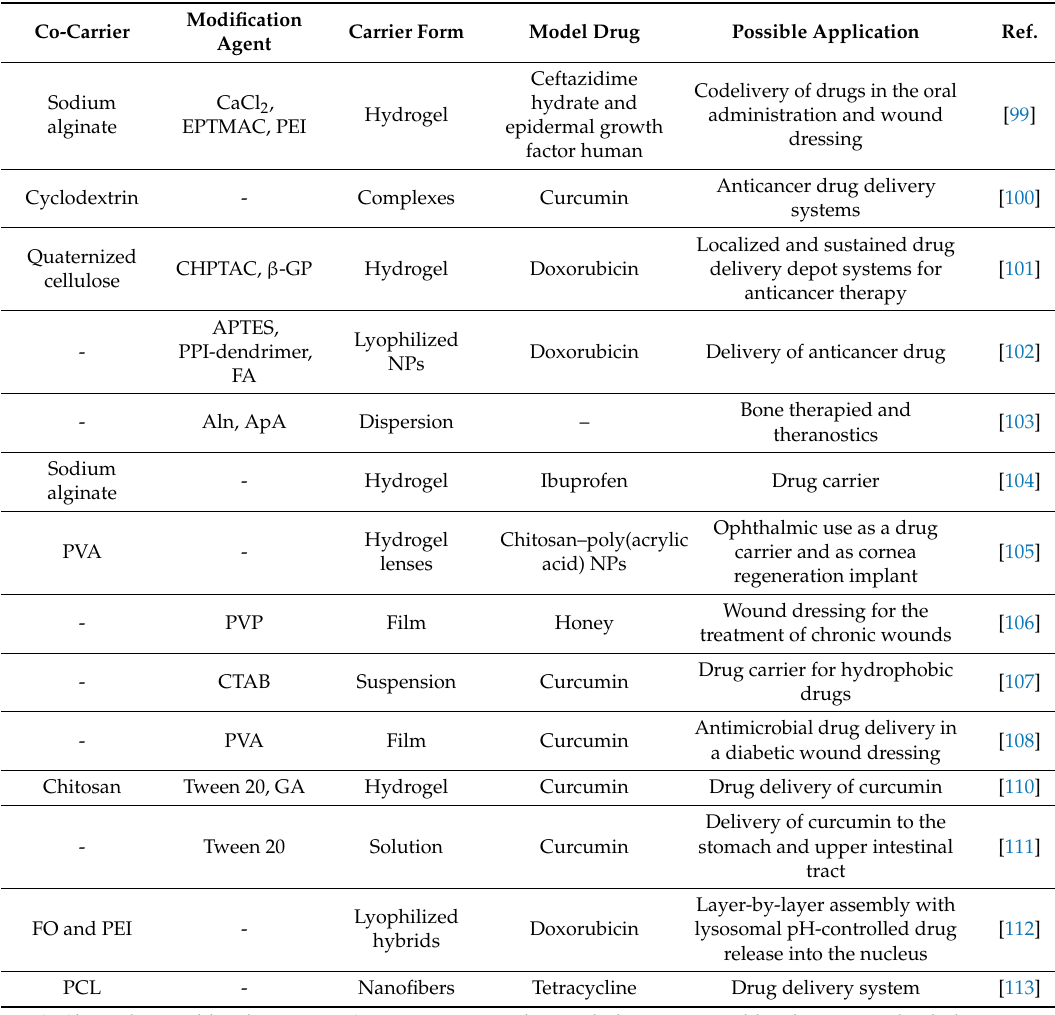
Table 1. Diverse CNC-based delivery systems with specific modification agents, carrier forms, model drugs, and potential